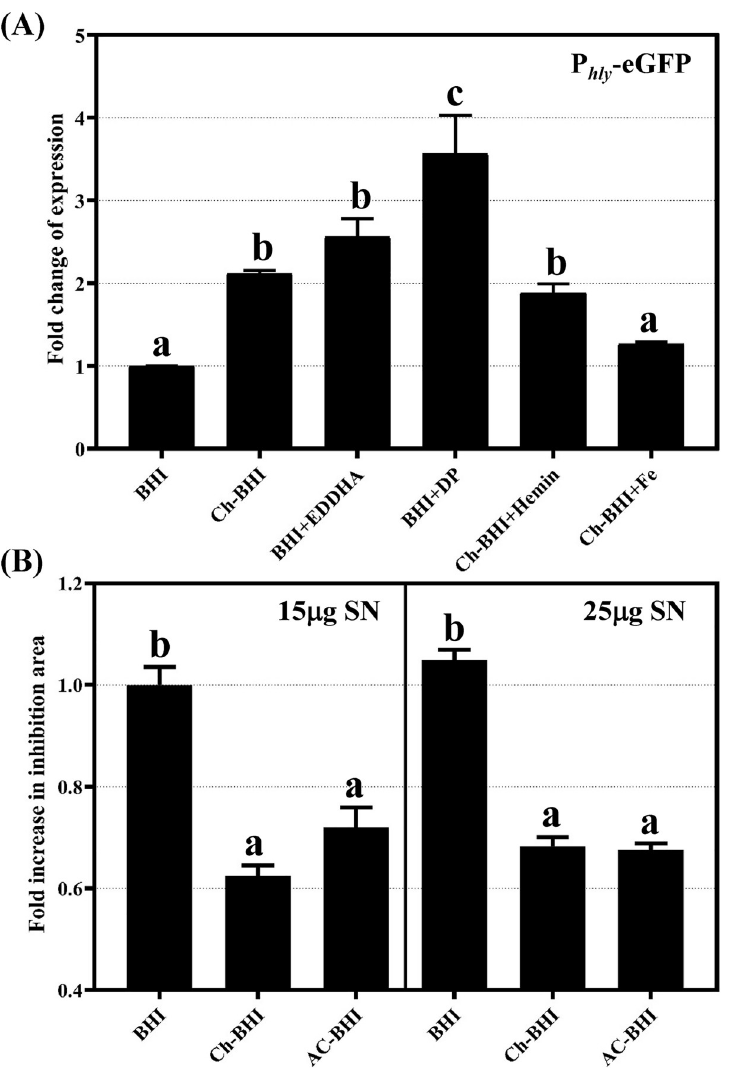
Fig 3. Intra- and extracellular iron depletion induces hly expression. (A) Effect of iron-specific chelators on expression of P hly -eGFP. An L . monocytogenes strain expressing a P hly -eGFP reporter fusion was grown in BHI or Ch- BHI in the presence of 100 μ M iron, 50 μ M hemin, 1mM dipyridyl (DP) or 1mM ethylenediamine-N,N 0 -bis (2-hydroxyphenylacetic acid) (EDDHA). GFP fluorescence levels were measured and normalized by culture OD 600 . Fold change of expression (for graphing purpose) was calculated as a ratio of normalized GFP fluorescence level relative to the normalized fluorescence level of L . monocytogenes cells expressing the reporter fusion and growing in untreated BHI. Data represent the mean of at least 3 independent biological replicates; error bars represent SEM. Bars that share the same letter are not significantly different ( p- value > 0.05) as determined by one-way ANOVA and Tukey’s post hoc test (B) Streptonigrin susceptibility of L . monocytogenes grown on BHI, Ch-BHI or AC-BHI plates. Zones of inhibition were measured around paper disks impregnated with 15mg or 25mg streptonigrin. Fold change in inhibition area was calculated in reference to inhibition area of a strain grown on BHI. Data represent the mean of at least 3 independent biological replicates; error bars represent SEM. Bars that share the same letter are not significantly different ( p- value > 0.05) as determined by one-way ANOVA and Tukey’s post hoc test. correlated to bioavailable iron levels [56]. Hence, we used streptonigrin to estimate the intra- cellular labile pool of iron; this approach has previously been used in different bacteria includ- ing in L . monocytogenes [57]. To assess the levels of free intracellular iron pools, we specifically tested streptonigrin susceptibility of L . monocytogenes grown on BHI, AC-BHI or Ch-BHI